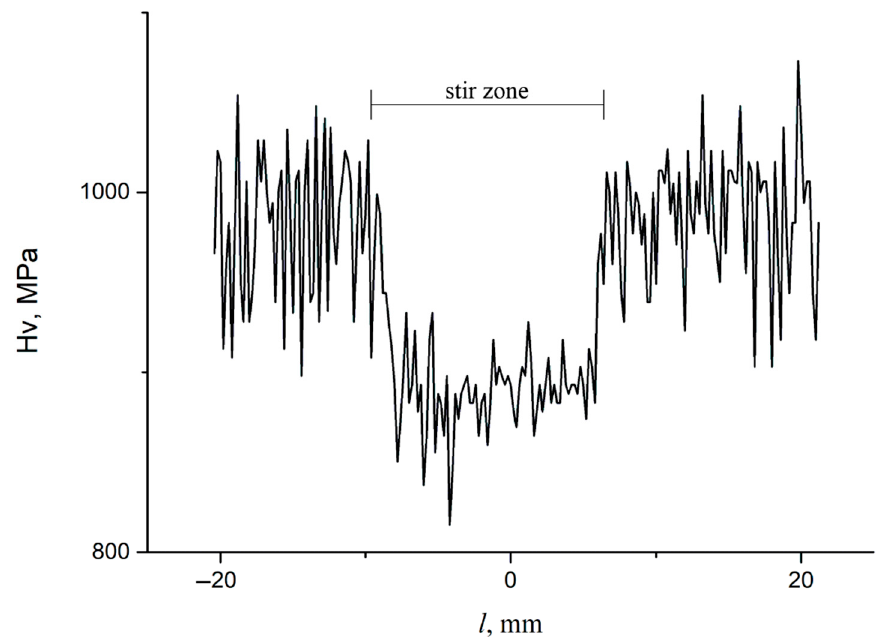
Figure 12. The microhardness profile across the FSW joint at 5 mm below the surface on 35 mm thickness metal.